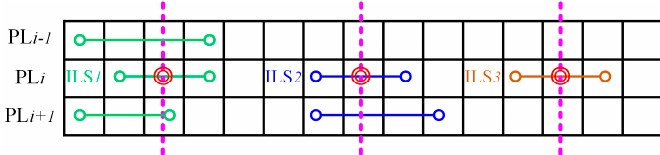
Figure 6. Interesting line segment (ILS) index refinement with adjacent profile lines (PLs).